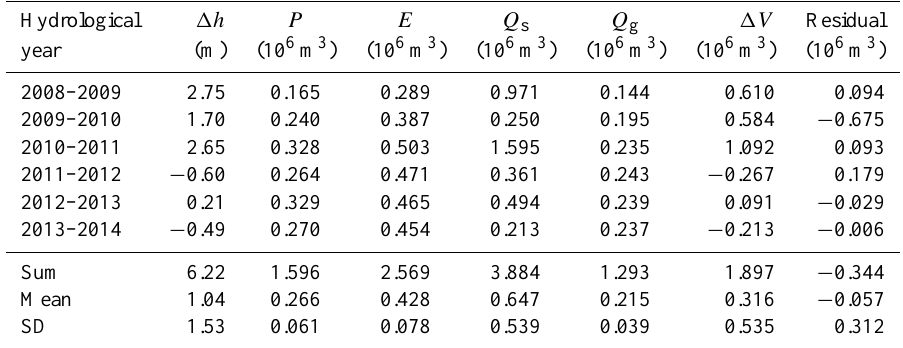
Table 2. Annual components of the lake water balance for the five hydrological years. P is precipitation, E is evaporation by BREB, Q s is surface runoff (inflow), Q g is net groundwater flow, (cid:49)V is the volume of the lake during the hydrological year, (cid:49)h is the measured lake water level. Residuals represent the errors on closing the water balance.